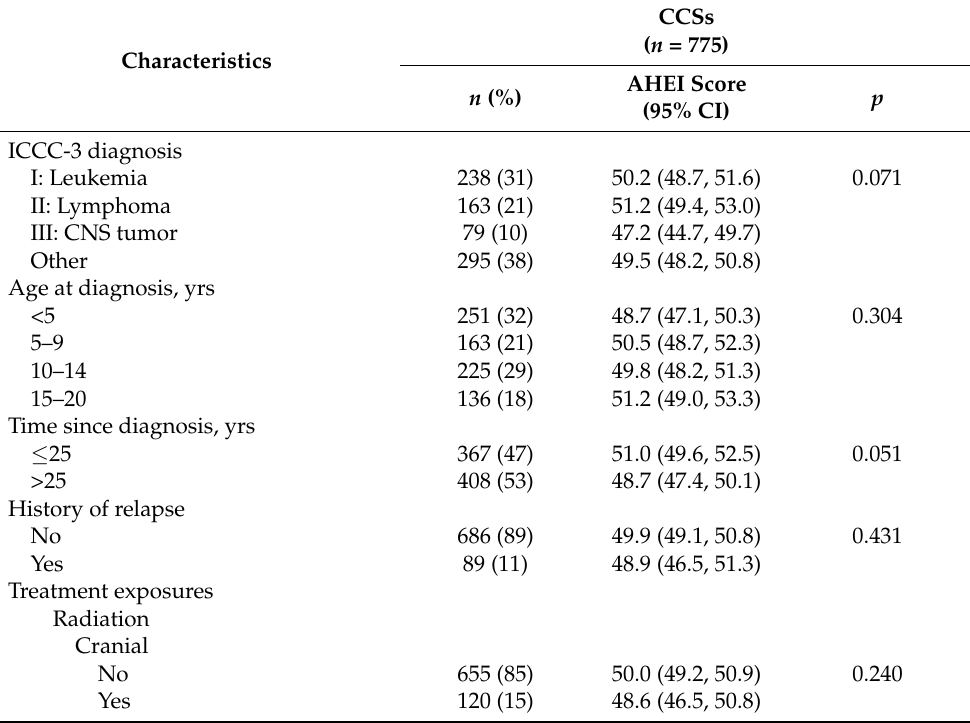
Table 2. Diet quality in childhood cancer survivors by clinical characteristics (retrieved from AN- COVA) a .